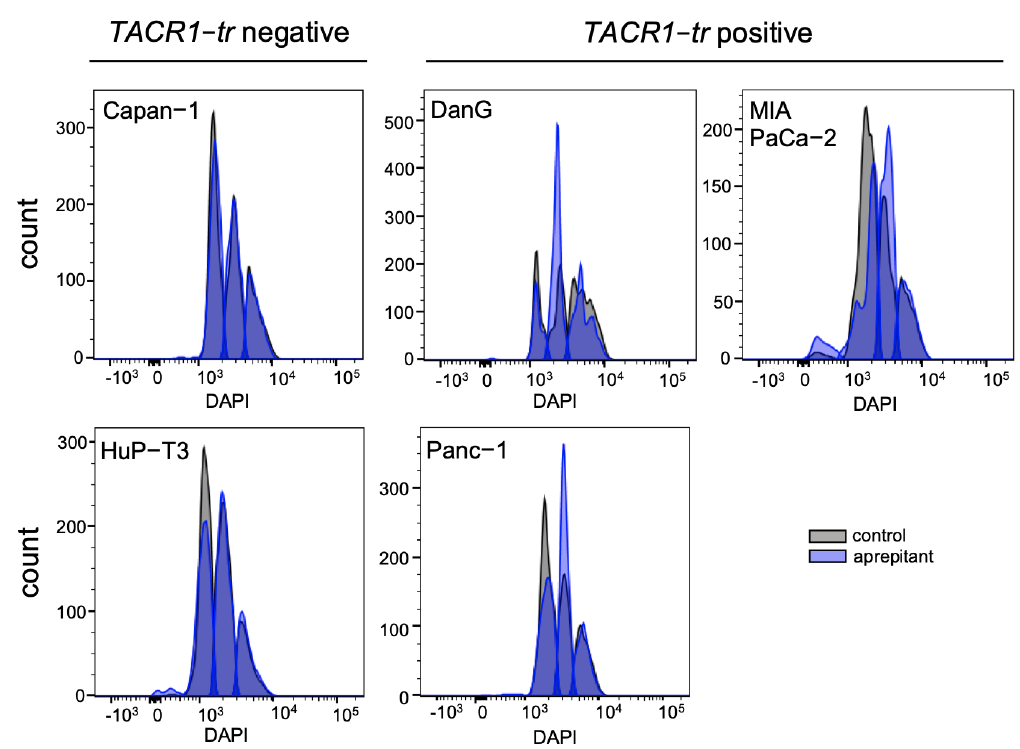
Figure 5. Evaluation of cell cycle progression in PDAC cells. Flow cytometry univariate histogram of DAPI staining in control vs. AP-treated cells showing number of events for cell cycle phases. Left panels: NK1R-tr negative cell lines demonstrate no difference in treatment. Right panels: a clear shift in cell cycle progression could be observed in NK1R-tr positive cell lines. The histogram of cell cycle distribution was generated from 10,000 events per sample. Appendix A provide more detailed information regarding the AP-induced shifts in cell cycle progression. Drugs were applied in the concentrations 25 µM of AP and 20 nM of SP.